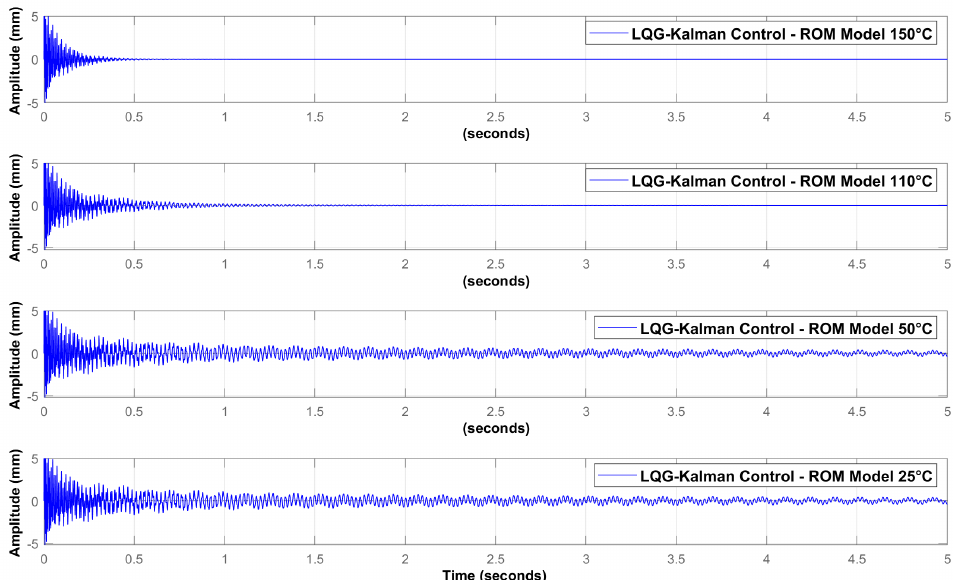
Figure 6. Impulse responses of control using reduced LQG-Kalman model for various temperatures with 5 distributed pairs of sensor/actuator and 10 selected sensors